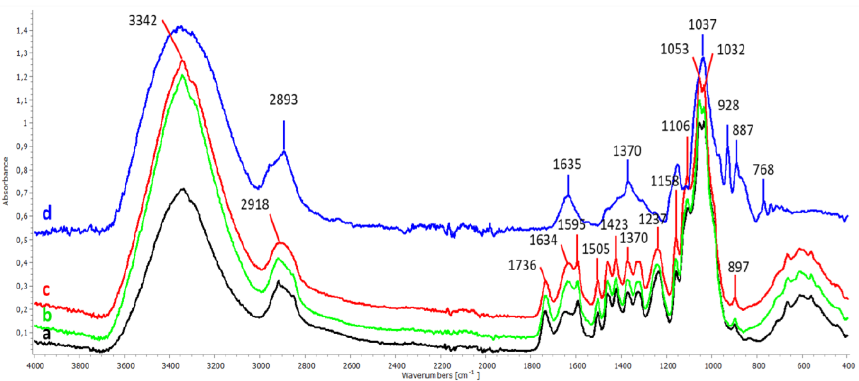
Figure 9. ATR-FTIR spectra of the control mock-ups after the 8th application of DFO-B at pH 8.6 ( b ) and pH 6.5 ( c ) in comparison to the spectrum acquired before application ( a ) and to a pure agarose spectrum ( d ). Table 2. Average ratios of the areas under the band maxima of aromatic lignin peak (1505 cm − 1 ) to typical carbohydrate peaks of wood (1736 cm − 1 , 1370 cm − 1 , 1237 cm − 1 and 897 cm − 1 ) of four replicates before and after 8 DFO-B hydrogel applications.